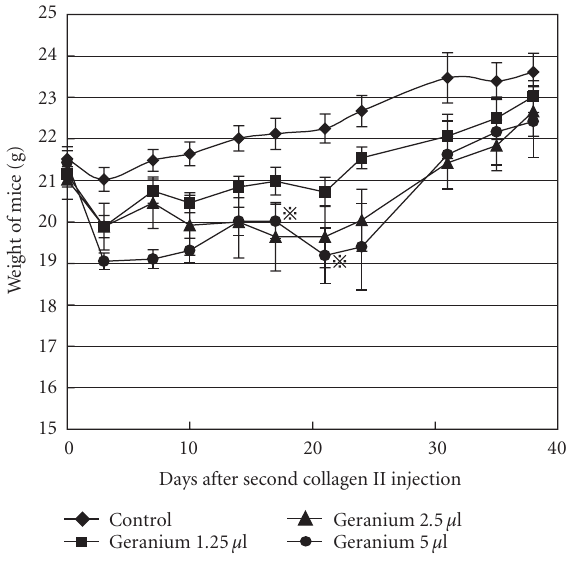
Figure 8: Changes in body weight during and after geranium oil injection to mice. Collagen II with CFA was subcutaneously injected to the base of the tail of the mice on days − 21 and 0. Geranium oils were injected from day 0 to 21, 5days/week. Each value represents an average of 5–10 mice and the standard error. (cid:2) : death of